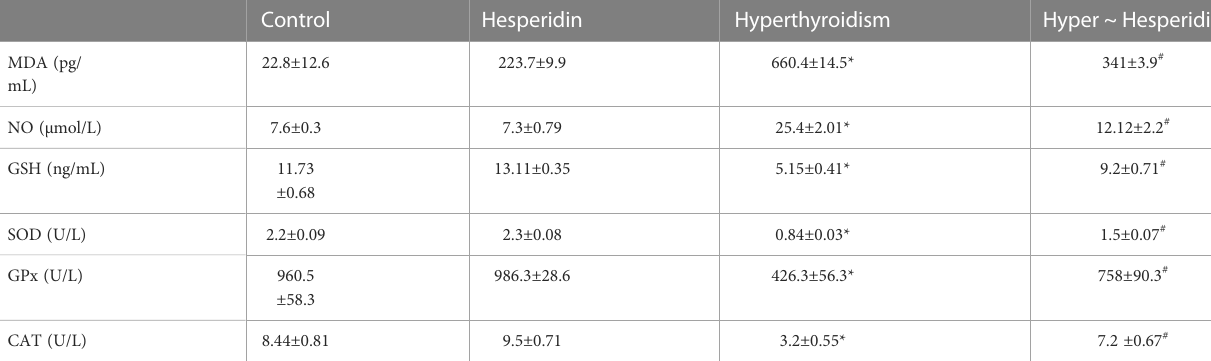
TABLE 3 Serum oxidant (MDA and NO) and antioxidant (GSH, SOD, GPx and CAT) markers of healthy and hyperthyroidism treated animals ’ groups as compared to control